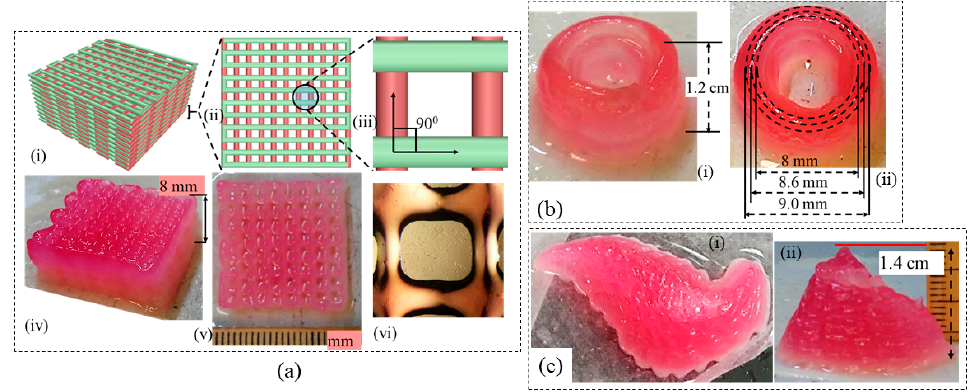
Figure 19. Large-scale scaffold fabricated by 4% Alg-4% CMC ( a ) CAD design (i–iii) with 0–90 deg pattern and corresponding fabrication (iv–vi); ( b ) a thin wall cylinder; ( c ) Pancreas structure